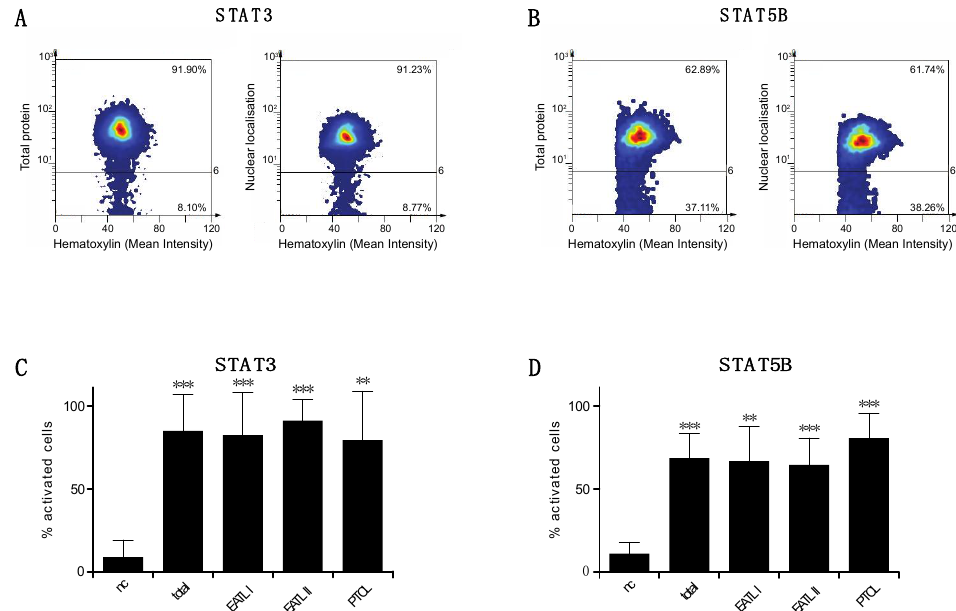
Figure 3. STAT3 and STAT5B are activated in feline alimentary lymphoma cells. ( A , B ) Cytometric analysis of tumour tissue stained for STAT3 and STAT5B by IHC as in Figure 2. Nuclei and cytoplasm of individual cells were determined by image analysis software as in Figure S2. Staining intensity of the indicated immunohistochemical marker was determined for each individual cell and for both cellular compartments, representative samples are shown. ( A ) Analysis of total cellular STAT3 in feline tumour cells. Right panel: Nuclear localisation of STAT3 in tumour cells. ( B ) Analysis of total protein content and nuclear localisation of STAT5B as in A. ( C ) Percentage of tumour cells showing activation of STAT3 as determined by the ratio of nuclear versus cytoplasmic staining. ( D ) Percentage of tumour cells showing activation of STAT5B as determined by the ratio of nuclear versus cytoplasmic staining. For both markers, activation was determined in total and for samples classified as EATL I, EATL II and PTCL-NOS. nc = negative control (normal feline liver tissue, Figure S2I), n = 15 (EATL type I), 17 (EATL type II) and 8 (PTCL-NOS), ** p < 0.001, *** p < 0.0001; error bars =